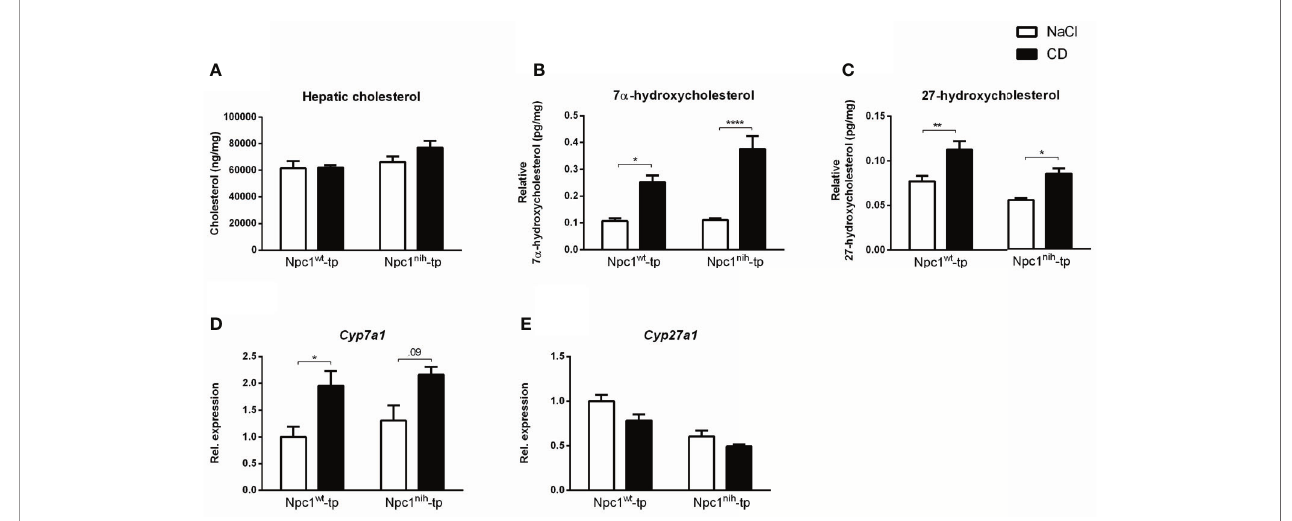
FIGURE 1 | Hepatic lipid parameters. (A) Hepatic cholesterol levels of Npc1 wt -tp and Npc1 nih -tp mice on a HFC diet that received CD or saline treatment. (B, C) Hepatic levels of the cholesterol degradation products 7 a -hydroxycholesterol and 27-hydroxycholesterol. (D, E) Hepatic gene expression analysis of Cyp7a1 (D) and Cyp27a1 (E) . n = 6-9 mice/group. Gene expression data are set relative to Npc1 w t -tp mice treated with saline. *, ** and **** indicate p ≤ 0.05, 0.01 and 0.0001 resp.by means of two-way ANOVA followed by Tukey post-hoc